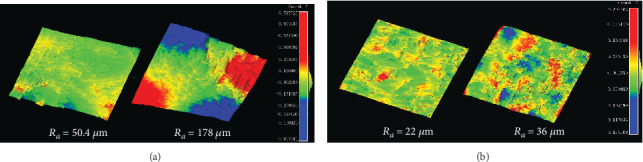
(a) 3D view of two typical tidemark surfaces with a small and large waviness index (SWa = 50.4μm and SWa = 178μm, respectively). (b) 3D view of two typical tidemark surfaces with a small and large roughness index (SRa = 22 μm and SRa = 36μm, respectively). A scale color bar in unit of mm is shown for the height mapping.